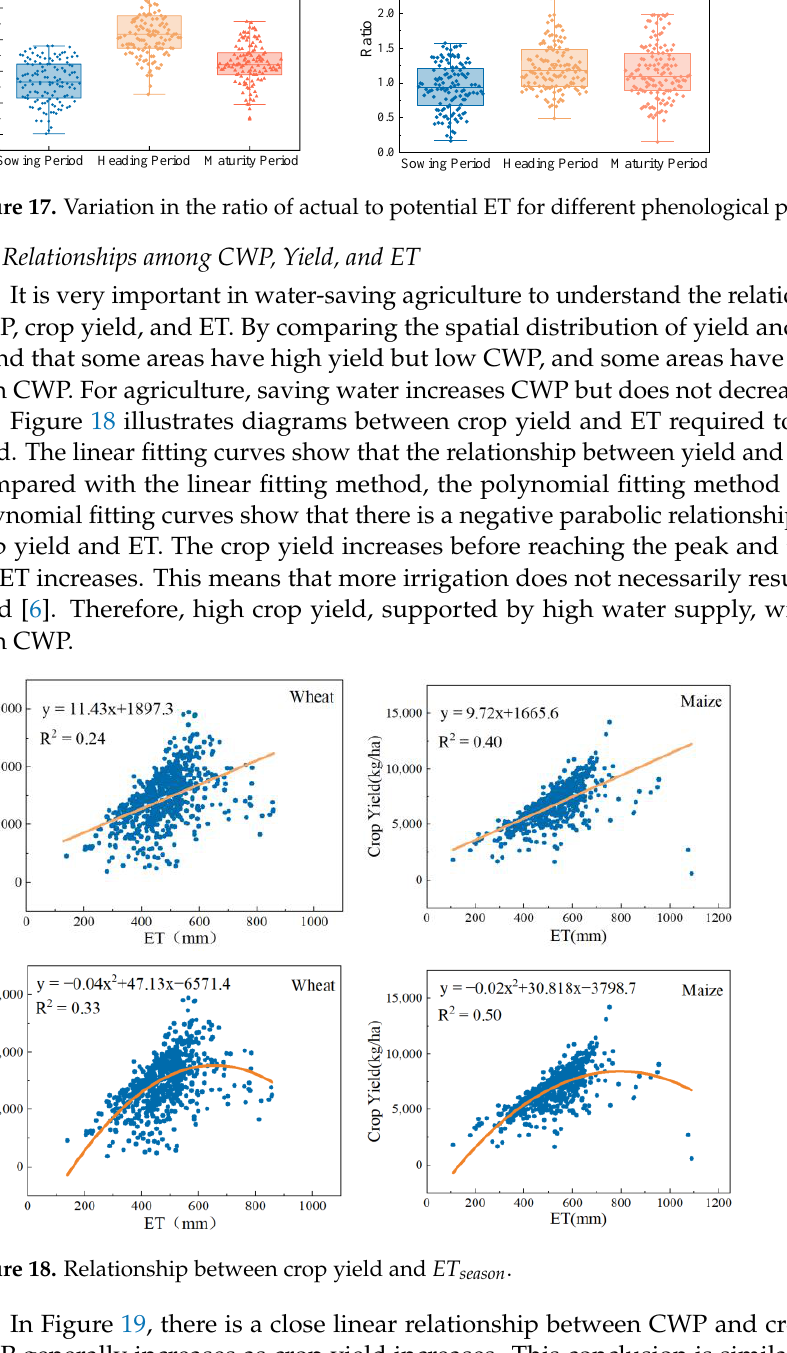
Figure 16. Variation in rainfall and temperature during the crop-growing season.